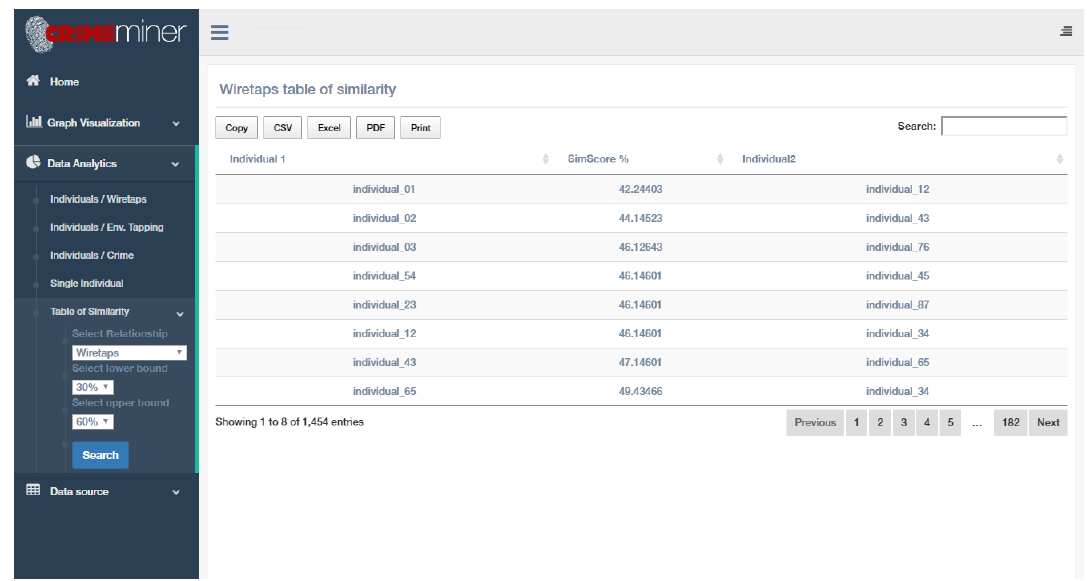
Figure 8. Similarity table using tabular data